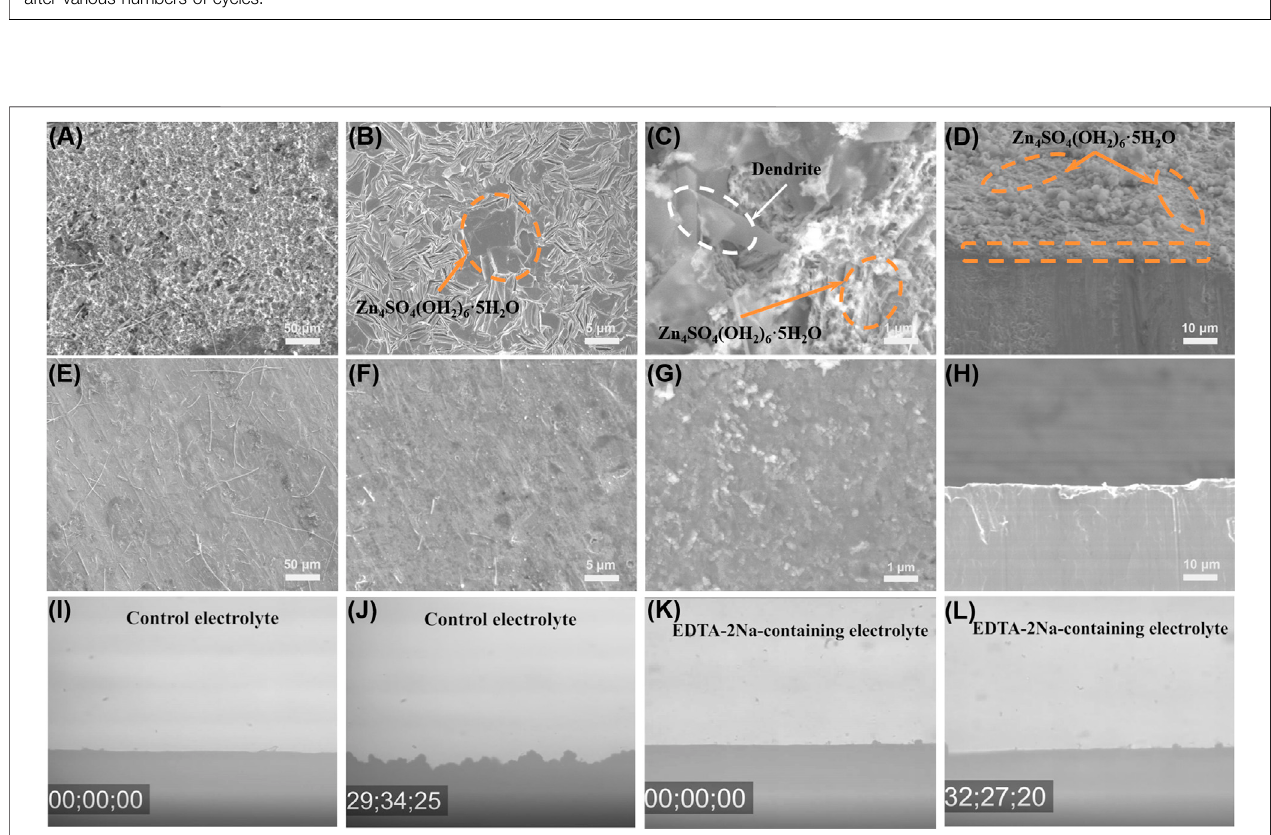
FIGURE4| GalvanostaticZnplating/strippinginZn||Znsymmetricalcellsat1 mA cm − 2 and1 mA h cm − 2 .SEMimagesofZnelectrodesinZn||Znsymmetricalcells after 20 plating/striping cycles at 1 mA cm − 2 and 0.5 mA h cm − 2 in (A – D) control electrolyte and (E – H) EDTA-2Na-containing electrolyte. In situ optical microscope photos of (I,J) control electrolyte and (K,L) EDTA-2Na-containing electrolyte.